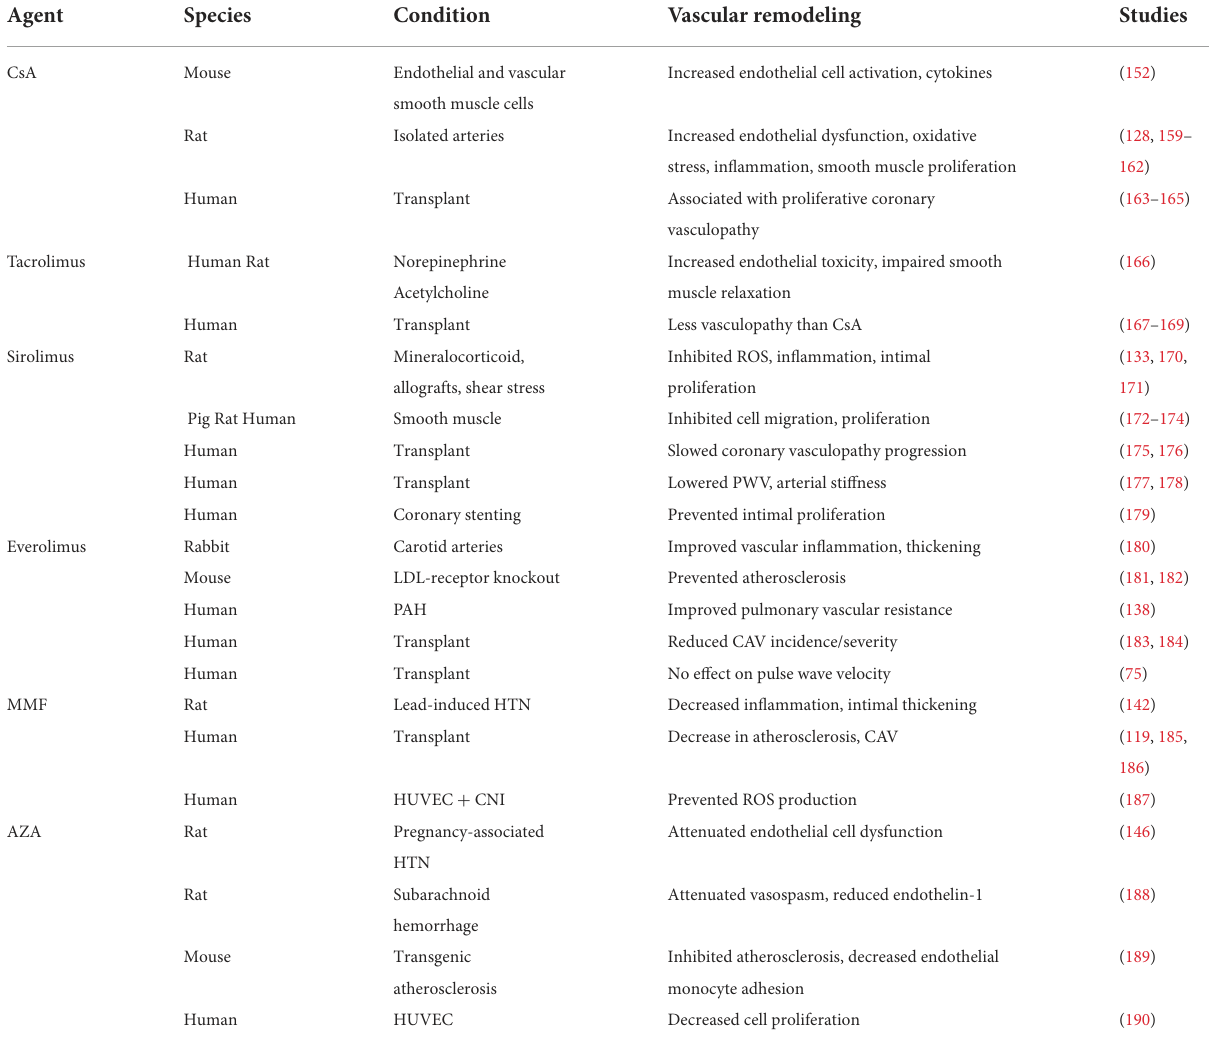
TABLE 5 Studies examining effects of immunosuppression on vascular